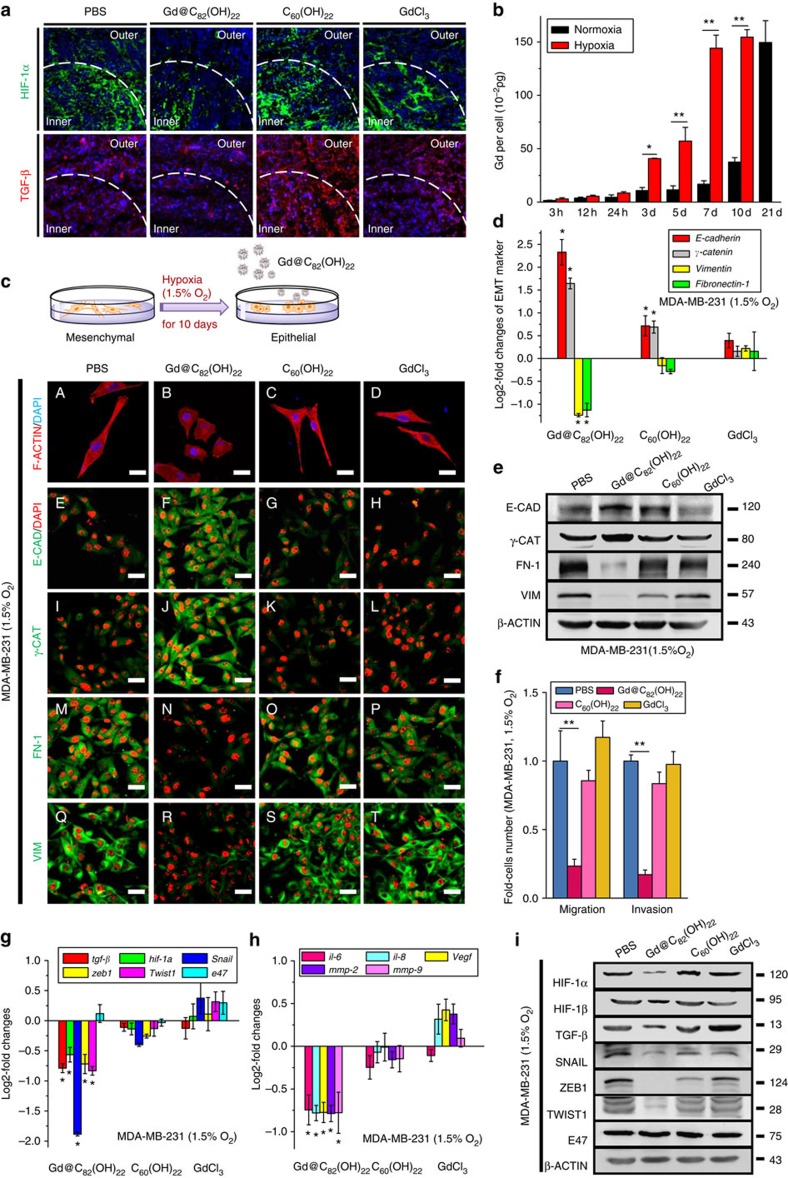
Gd@C82(OH)22 impaired EMT under hypoxia.A total of 1 × 106 MDA-MB-231 cells were injected s.c. and mice were treated at day 0 for 21 days. (a) HIF-1α and TGF-β expression in the periphery and inner portions of tumours. Scale bar, 20 μm. (b) The amount of intracellular Gd after MDA-MB-231 cells were treated with 50 μM Gd@C82(OH)22 under hypoxia and normoxia were detected by ICP-MS (mean±s.e.m., n=3 each). *P<0.05, **P<0.01 (two-way ANOVA, Bonferroni’s post-hoc test). (c) MDA-MB-231 cells were cultured under hypoxia and treated with PBS (A, E, I, M, Q), 50 μM Gd@C82(OH)22 (B, F, J, N, R), C60(OH)22 (C, G, K, O, S) and GdCl3 (D, H, L, P, T) for 10 days. (A–D) F-ACTIN cytoskeleton of cells (scale bar, 12.5 μm). Immunofluorescence staining (c, E-T), qPCR (d) and western blot analysis (e) of E-CADHERIN (E-CAD), γ-CATENIN (γ-CAT), VIMENTIN (VIM) and FIBRONECTIN-1 (FN-1) of MDA-MB-231 cells under hypoxia. (f) Cell migration and invasion were examined using trans-well cell culture chambers and Matrigel-coated ones (mean±s.e.m., n=6 each). **P<0.01 (one-way ANOVA, Tukey’s post-hoc test). mRNA levels of hif-1α, hif-1β, tgf-β, snail, zeb1, twist1, e47 (g), il-6, il-8, mmp-2, mmp-9 and vegf (h) were analysed by qPCR (mean±s.e.m., n=3 each). (i) Protein levels of HIF-1α, HIF-1β, TGF-β, SNAIL, ZEB1, TWIST1 and E47 were detected by western blot.